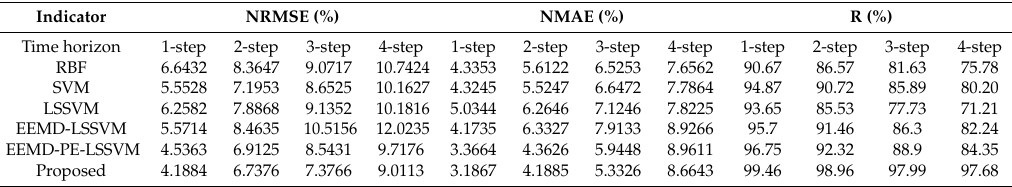
Table 4. The values of NRMSE, NMAE and R for six models in Dataset A.